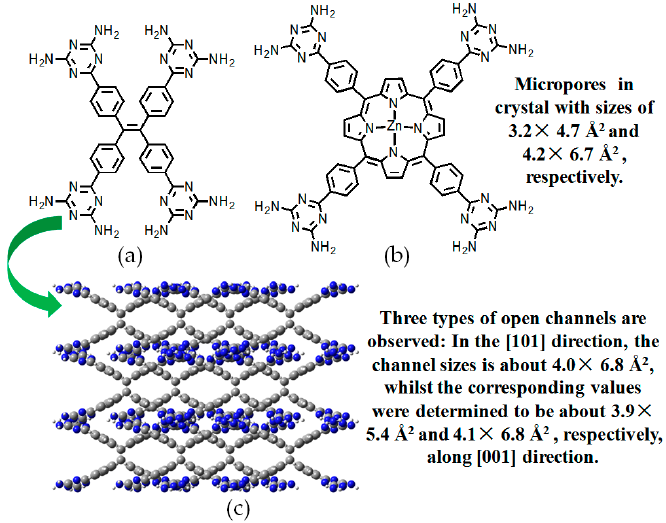
Figure 29. Structures of building motif 31 ( a ) and 32 ( b ); ( c ) Porous crystalline network of H31